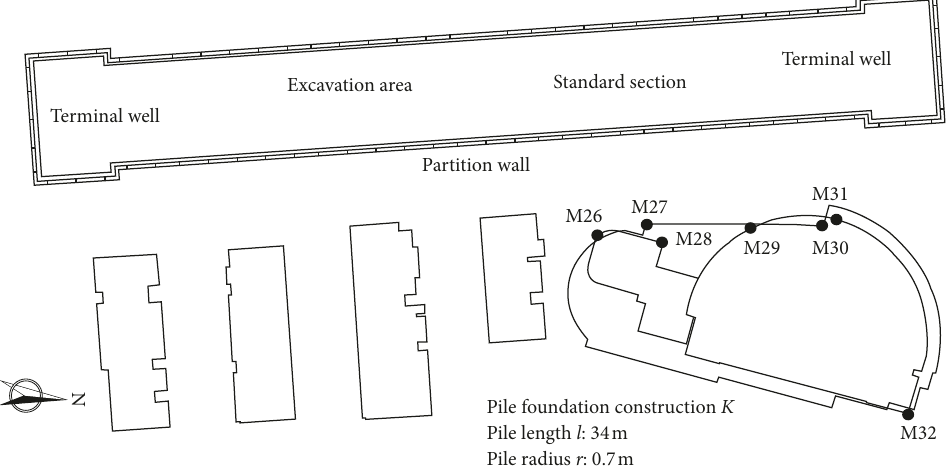
Figure 13: Plan of Wulin Road metro station and adjacent buildings. M26–M32 are the pile